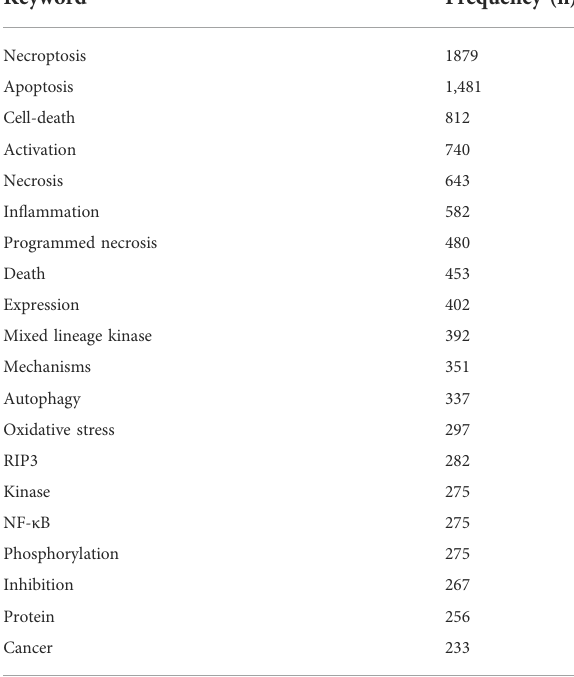
TABLE 5 The top 20 keywords related to necroptosis